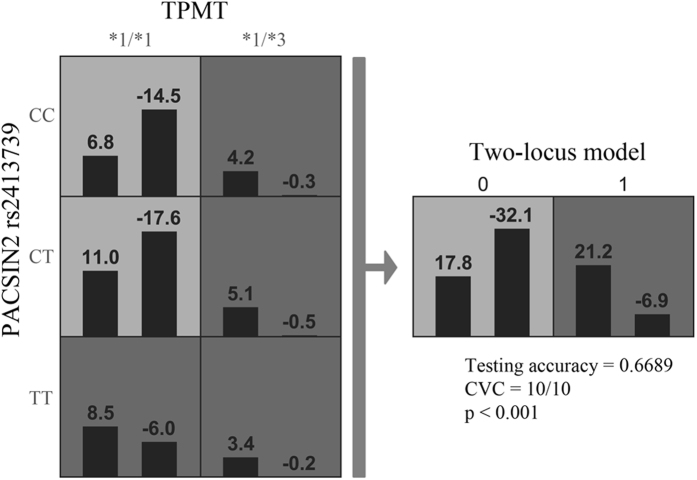
The result of the best overall GMDR model for hematotoxicity after adjustment for treatment protocol, age at diagnosis and gender.The plot shows in each cell a positive score (left bars) and a negative score (right bars), which was calculated in the GMDR model after treatment protocol, gender and age at diagnosis adjustment for each genotype combination. Based on determined score statistics patients in each cell were assigned to have either a high-risk or low-risk genotype (shaded dark grey and light grey, respectively). TPMT *1/*3 denotes a heterozygous genotype (*1/*3A or *1/*3C). In the two-locus model “0” presents low risk group (patients with wild-type TPMT and PACSIN2 rs2413739 CC or CT) and “1” presents high-risk group (patients with heterozygous TPMT genotype and wild-type TPMT patients with PACSIN2 rs2413739 TT genotype).